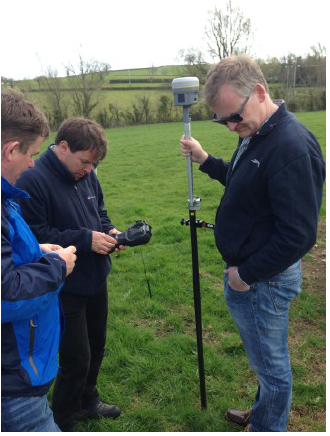
Figure 6: GPS measurements